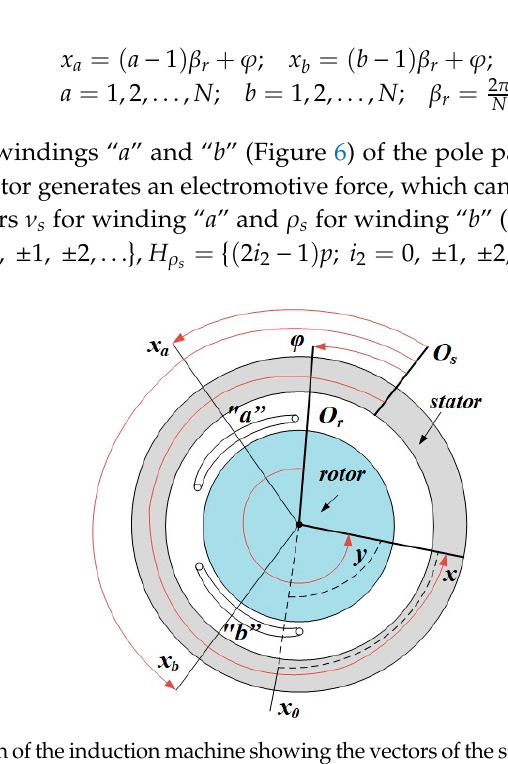
Figure 6. Cross-section of the induction machine showing the vectors of the stator and rotor magnetic